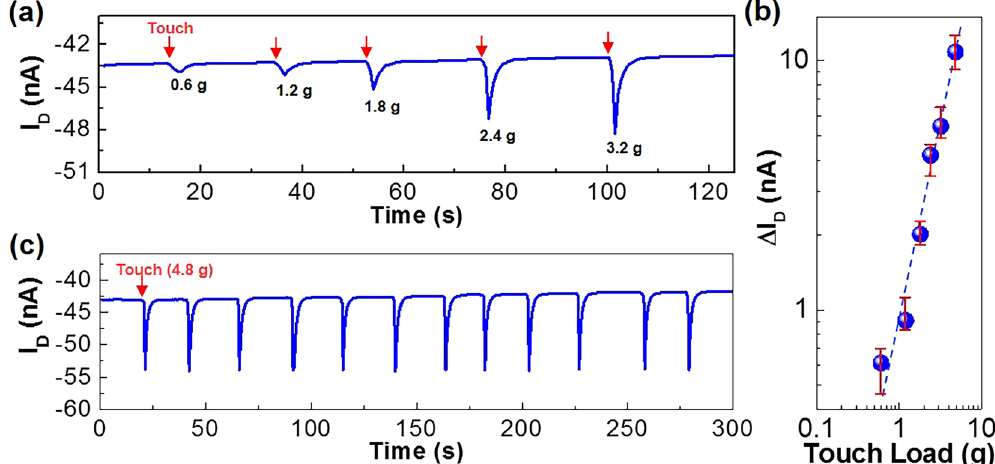
Figure 3. Sensing performances by direct physical touches. ( a ) Drain current (I D ) response upon direct physical touch with various loads (0.6~3.2 g) from the flexible PDLC-i-OFET devices at V D = − 1 V and V G = − 5 V. ( b ) Net drain current change ( Δ I D ) as a function of physical load in ( a ) (note that more than sixteen devices were measured). ( c ) Drain current response upon repeated direct physical touches with 4.8 g